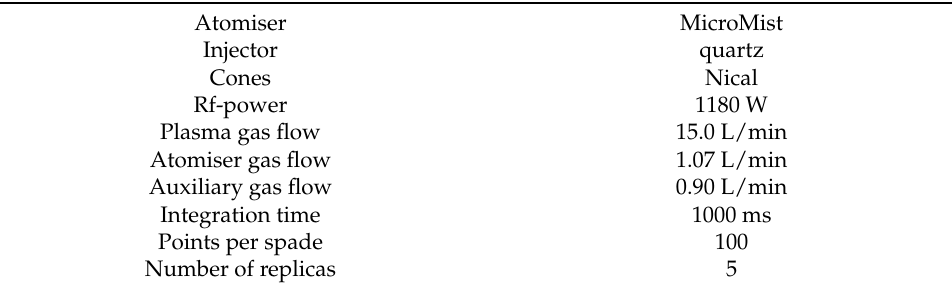
Table 2. Chromatographic conditions of